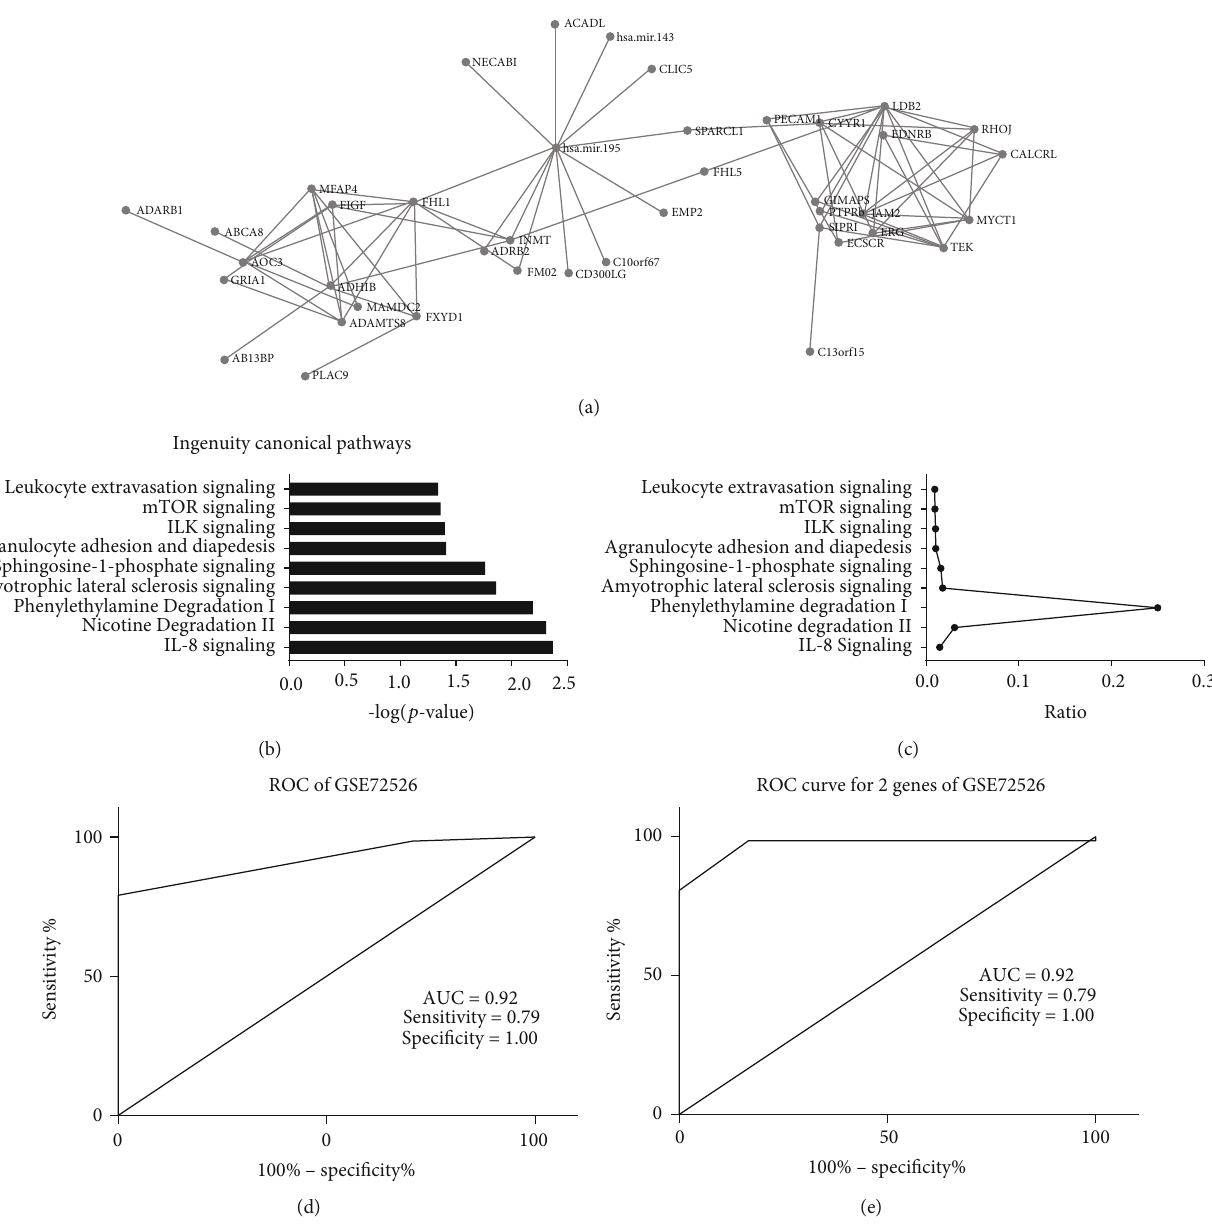
Figure 4: Coexpression network and Ingenuity Pathway Analysis of hsa-miR-195 in the TCGA lung cancer patients The ROC curve of hsa-miR-195 combined with hsa-miR-143 to distinguish lung cancer patients and normal controls in another two datasets. (a) The network analysis shows another microRNA highly correlated with hsa-miR-195 . (b, c) Ingenuity Pathway Analysis shows that the IL-8 signaling pathway was the most important pathway in this network. (d, e) The combination of hsa-miR-195 and hsa-miR-143 has a better performance in distinguishing lung cancer patients and normal controls compared with hsa-miR-195